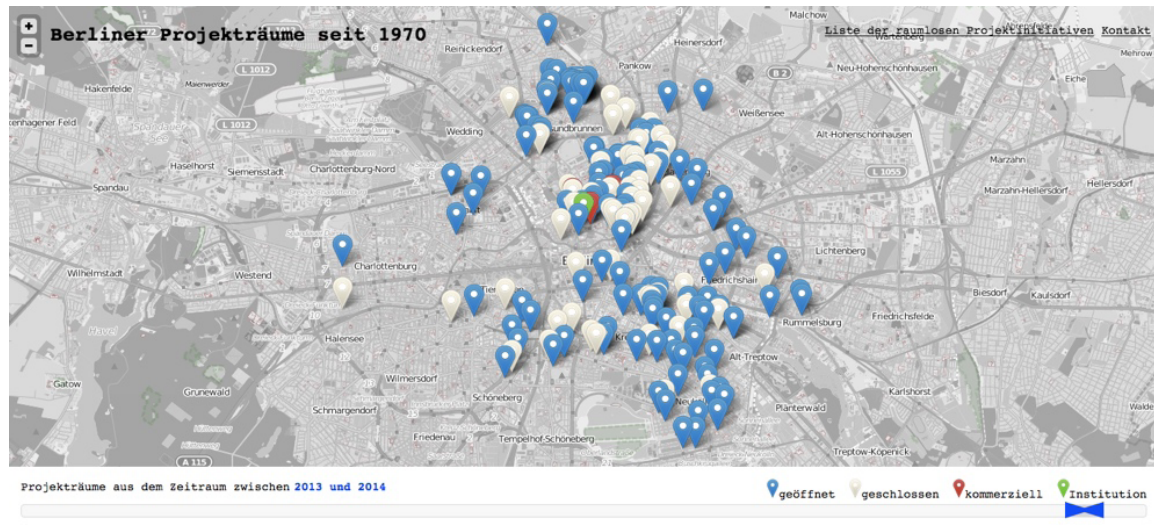
Interaktive Projekträumekarte, 2013-2014. Powered by Leaflet—Projektraum- daten und Webseite/Data and Webside: Séverine Marguin und Erik Streb del Toro. Data https://openstreetmap.org. Titles: http://wikimedia.org/ and http://